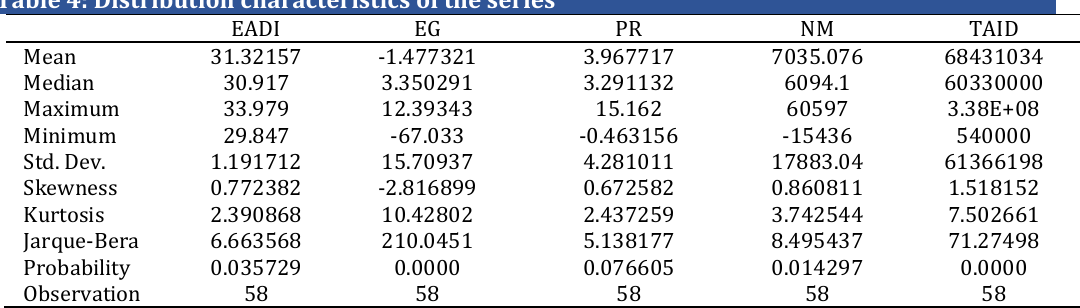
Table 4: Distribution characteristics of the series